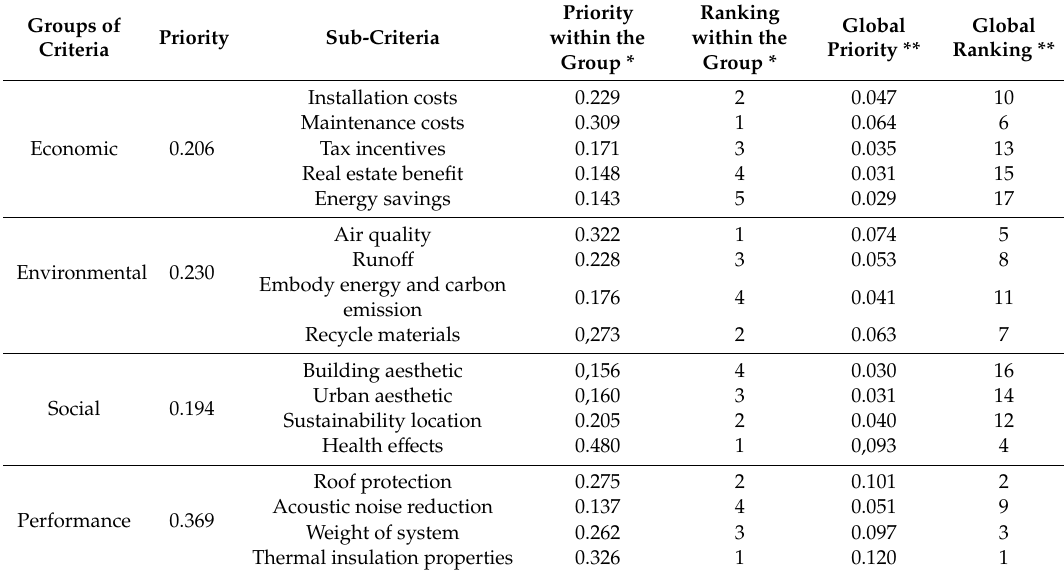
Table 4. Priorities of criteria and sub-criteria.